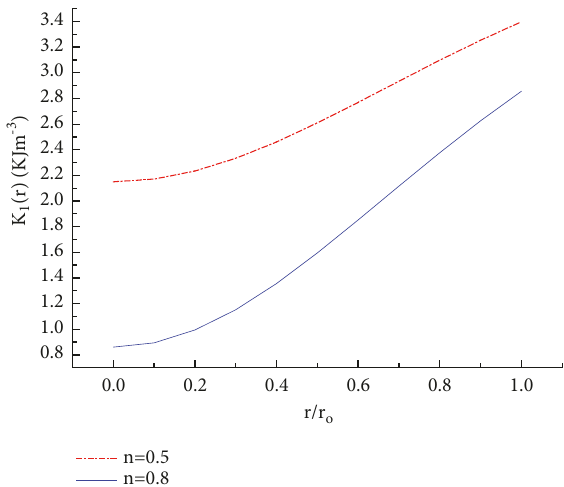
Figure 1: Variations of anisotropy K 1 (r) in inhomogeneous area. where 𝐴 𝑖,𝑖+1 corresponds to the local exchange constant between adjacent layers i and i+1. Similarly, 𝐾 𝑖 1 corresponds to the local anisotropy constant of the ith layer. 𝛿 𝑚 is the wall width. The term 𝑁 eff 𝑀 s takes care of demagnetization fields resulting from grain surfaces and volume charges.